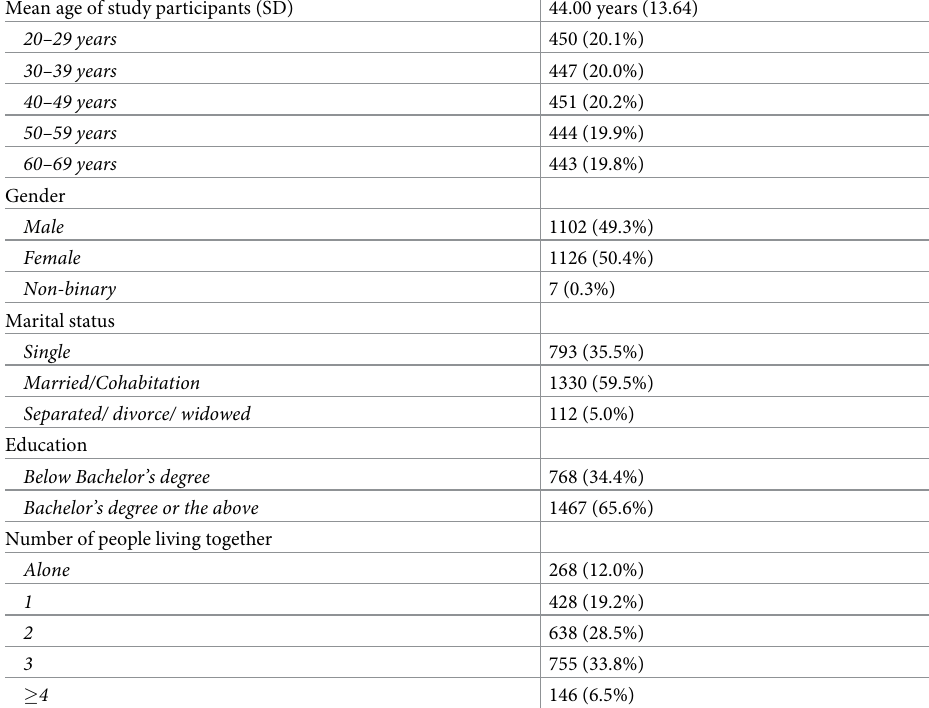
Table 1. Socio-demographic profile. (N =